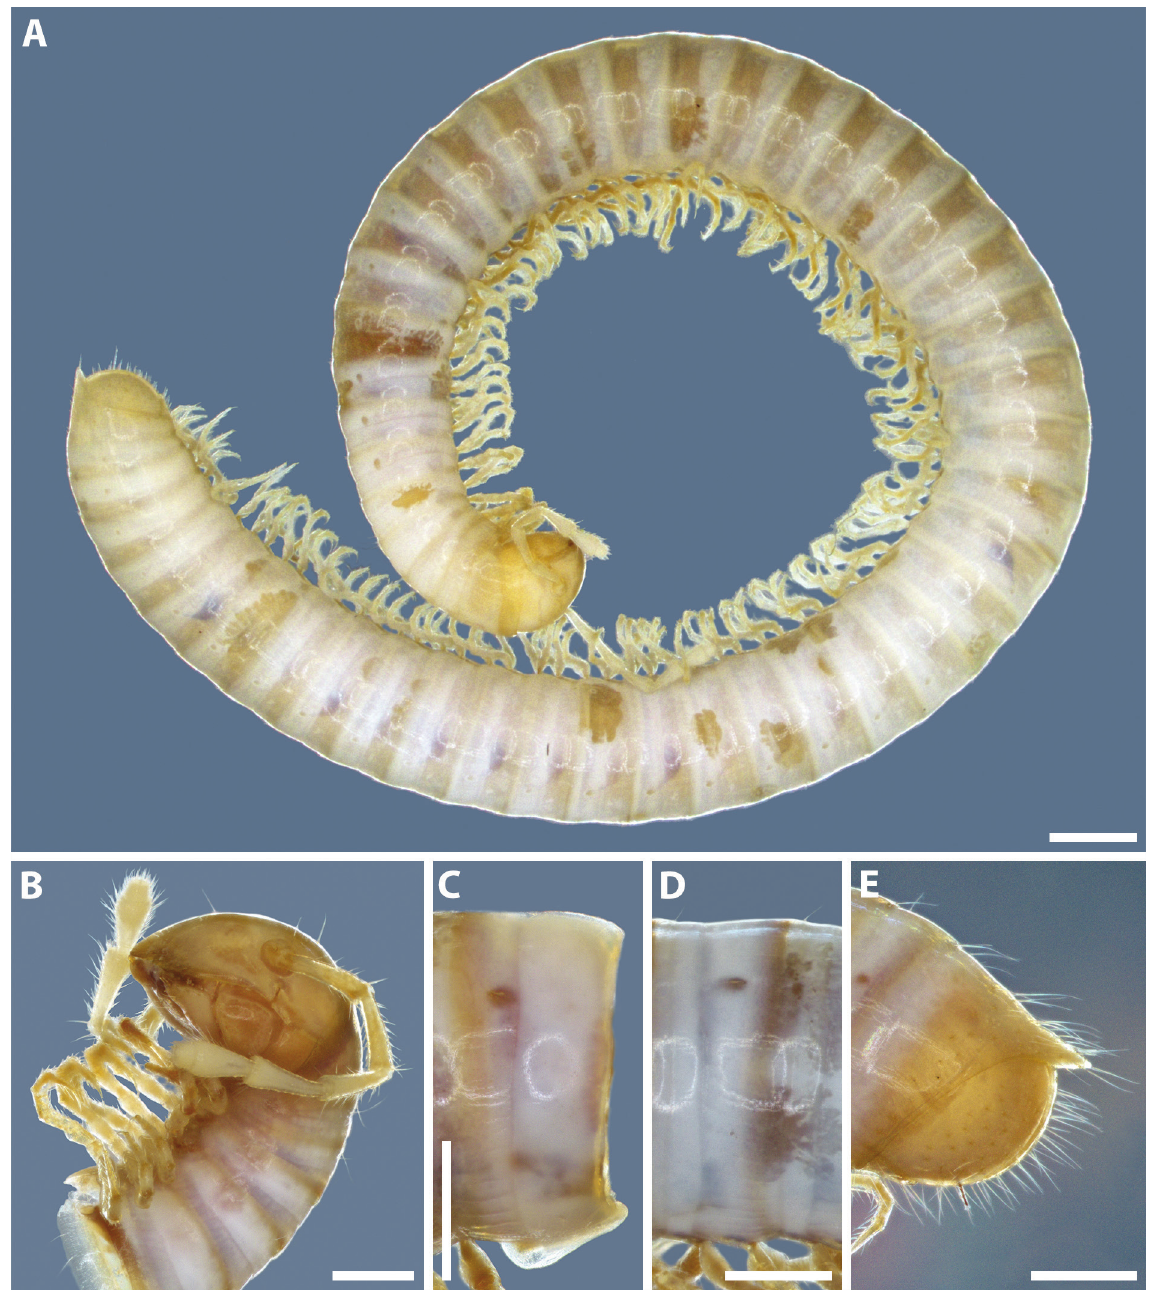
Fig . 8. Stygiiulus rotundatus (Strasser, 1962) comb. et stat. nov., ♀ (A) and ♂ (B–E) from La Bora Cave (NHMD). A . Habitus, lateral view. B . Anterior part of body, lateral, slightly ventral view. C . Pleurotergum 7, lateral view. D . Mid-body rings, lateral view. E . Telson, lateral view. Scale bars: A = 1 mm; B–E = 0.5